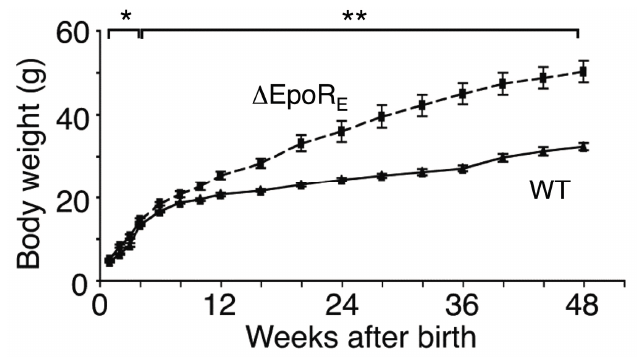
Figure 4. EpoR expression in non-hematopoietic tissues regulates body weight